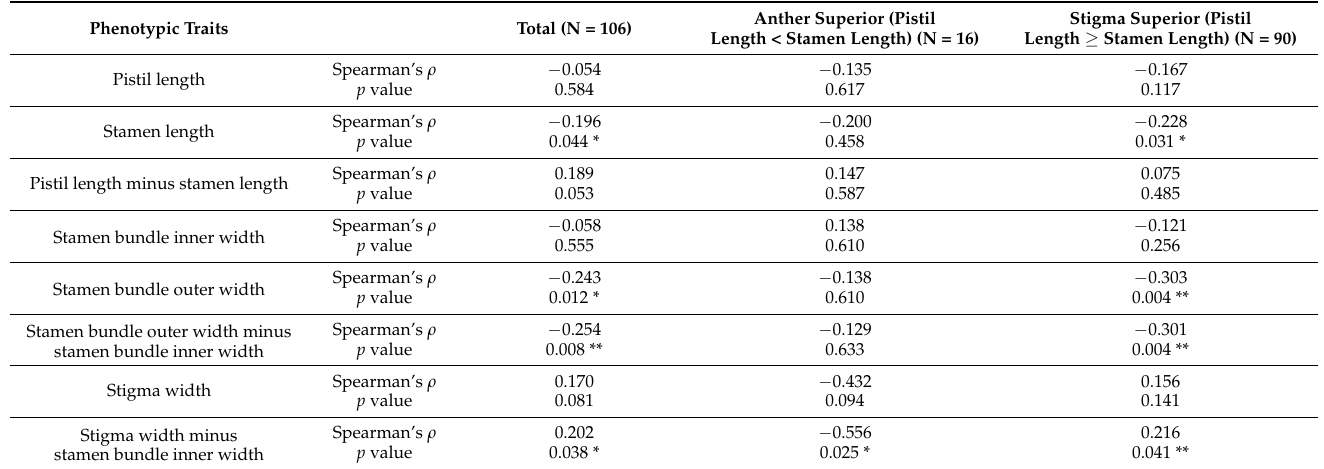
Table 3. Correlations of yield versus phenotypic traits by group on the average yield of tea plants at two